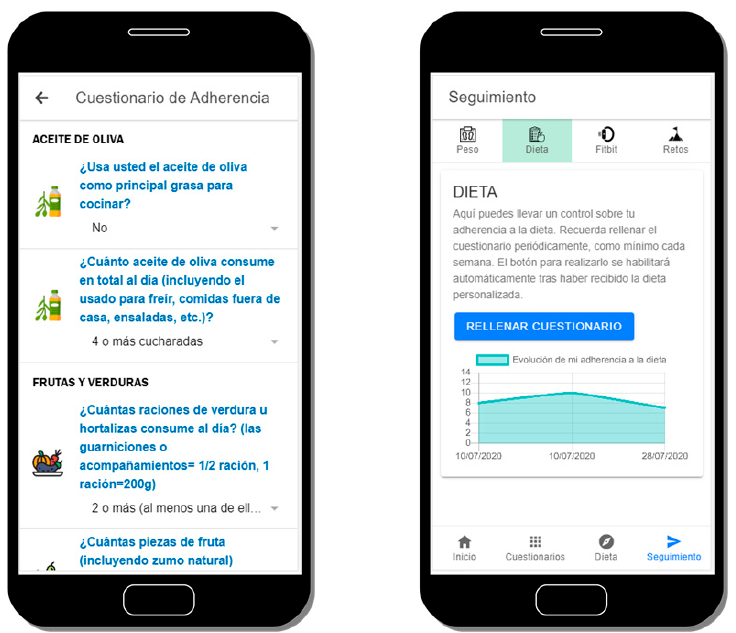
Figure 5. Detail of the Mediterranean Diet adherence questionnaire (left) and its corresponding score evolution (right).